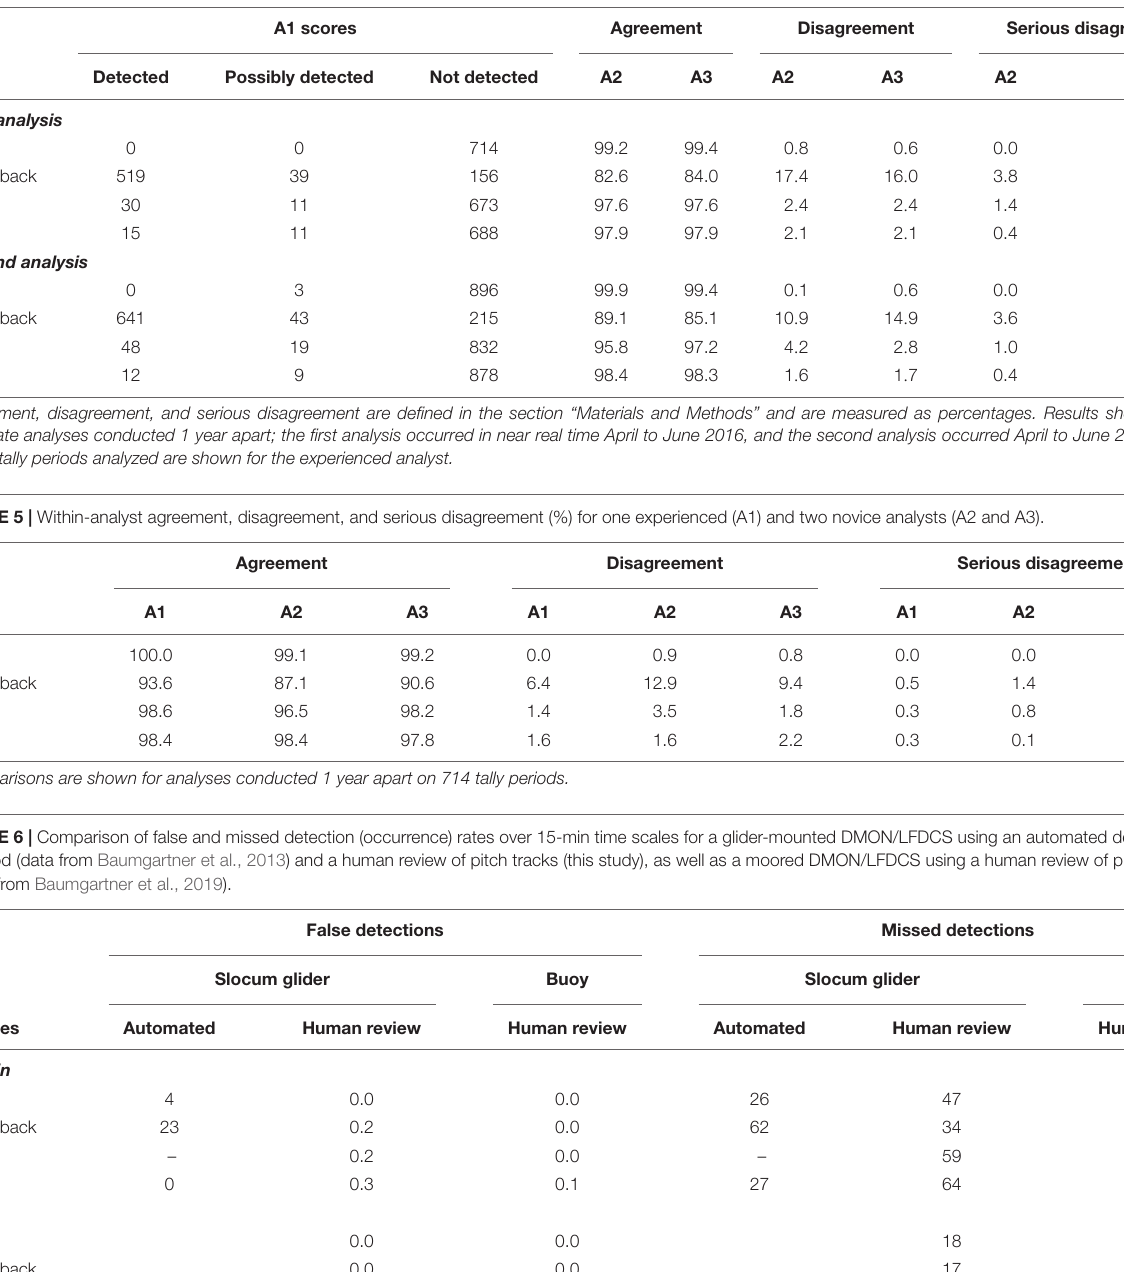
TABLE 4 | Between-analyst agreement, disagreement, and serious disagreement for two novice analysts (A2 and A3) compared to an experienced analyst (A1).